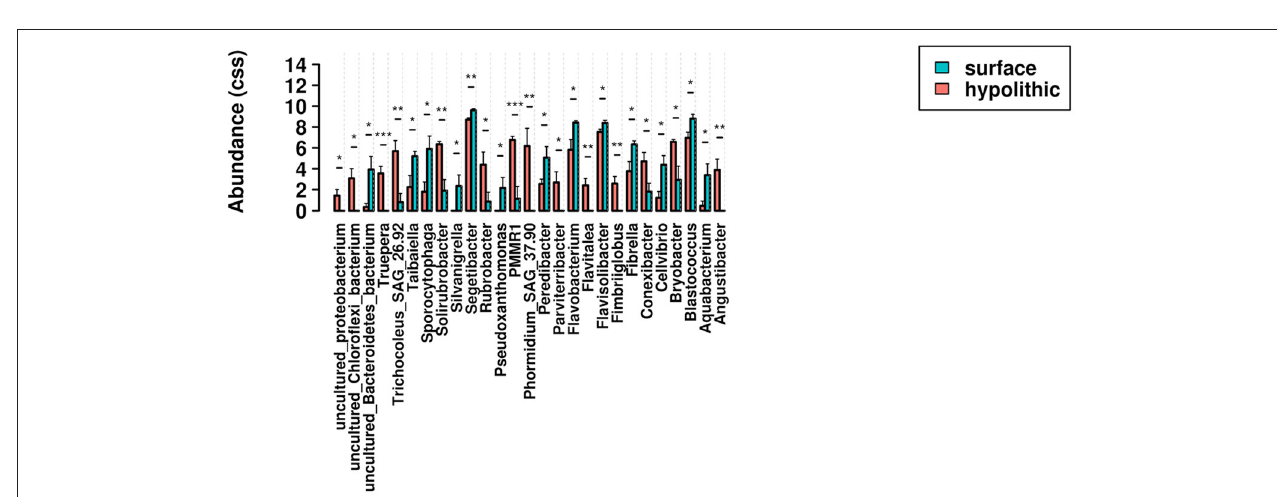
FIGURE 8 | Relative abundance of genera found to be differentially abundant in an ANOVA comparison of surface and hypolithic biocrusts without moss. Bars indicate significant pairwise differences at * ≥ 0.05; ** ≥ 0.01; *** ≥ 0.001.